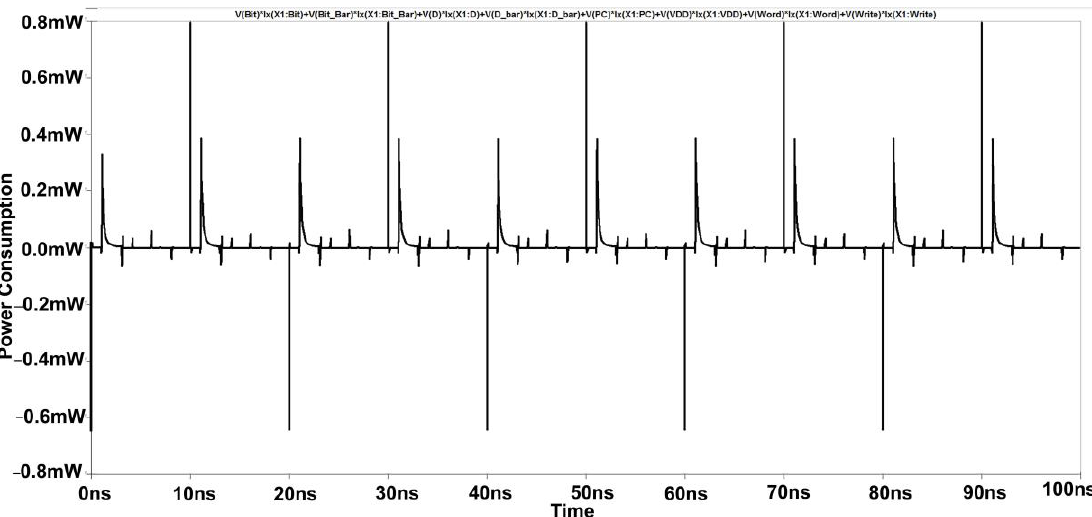
Figure 17. Power Consumption Spectrum of Commonly Cross Coupled Sense Amplifier.